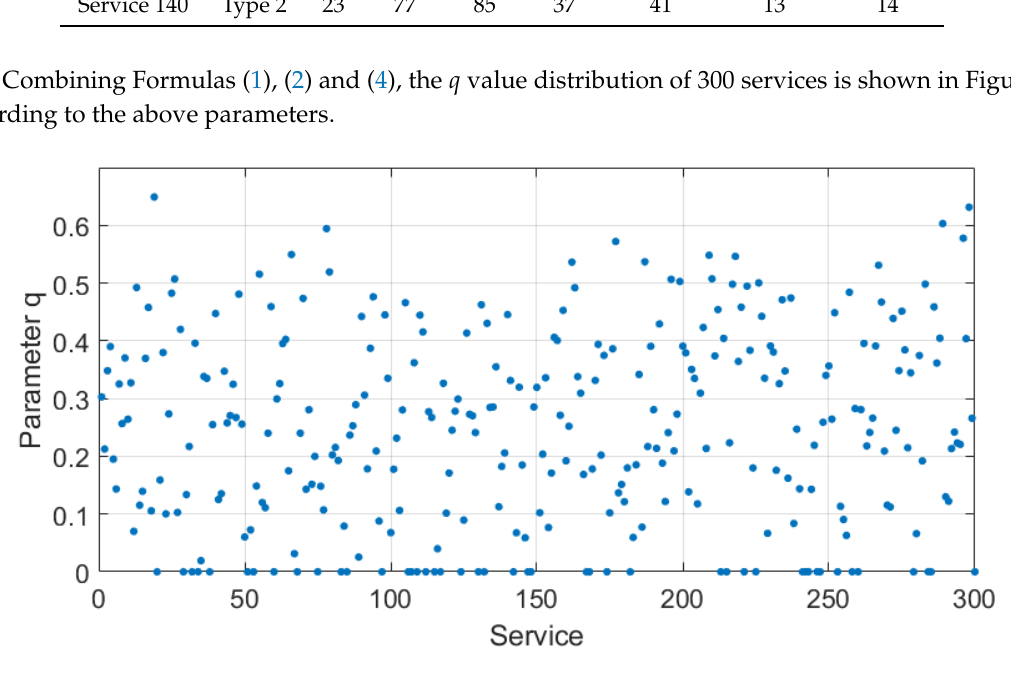
Figure 2. Parameter q distribution of 300